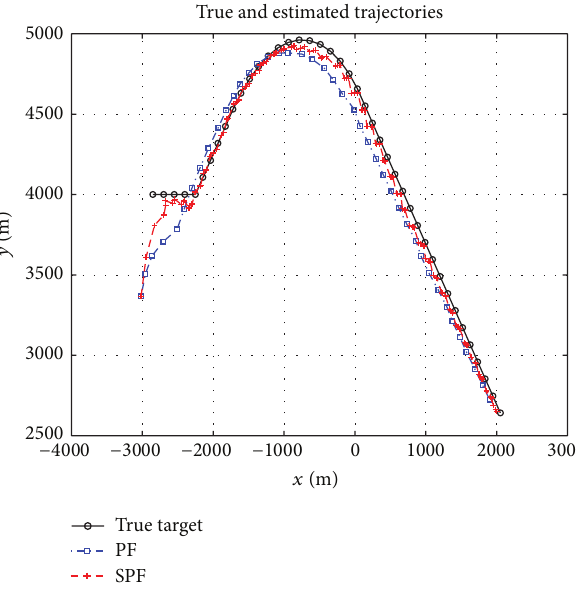
Figure 10: Range errors during each iteration (one trial). direction noise, (2) basic flight maneuvers, and (3) multiple targets.